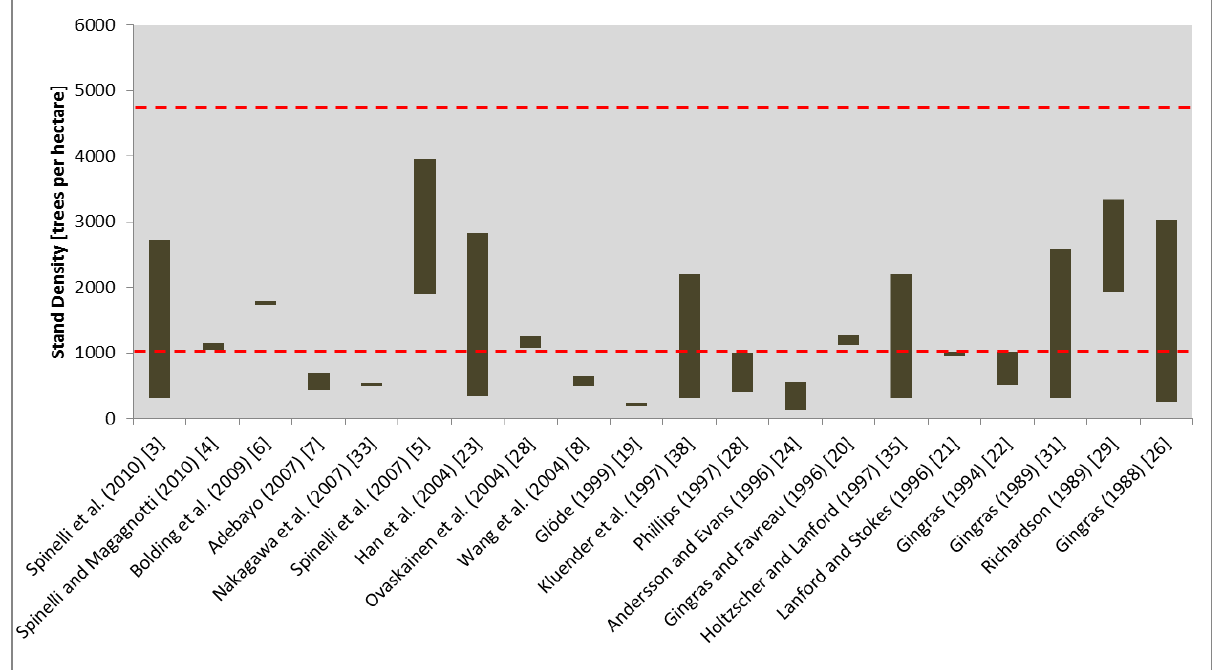
Figure 3. Summary of the variation in stand density among several harvesting equipment productivity studies. Dashed red lines represent the upper and lower stand density limits of interest in Maine for whole-tree and cut-to-length harvesting